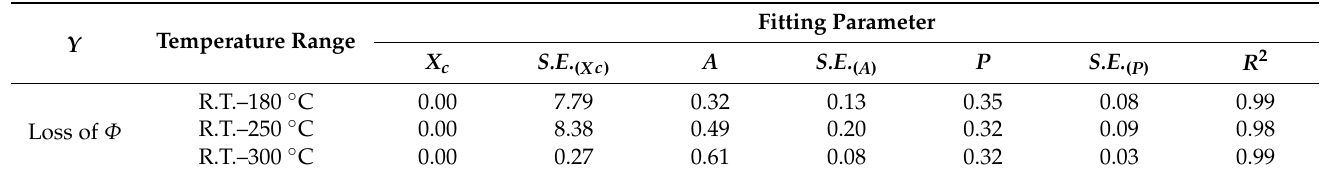
Table 2. Values of fitting parameters and their standard errors ( S.E. ) in the different temperature ranges. The fitting formulae are given by Y = A × ( X − X c ) P .